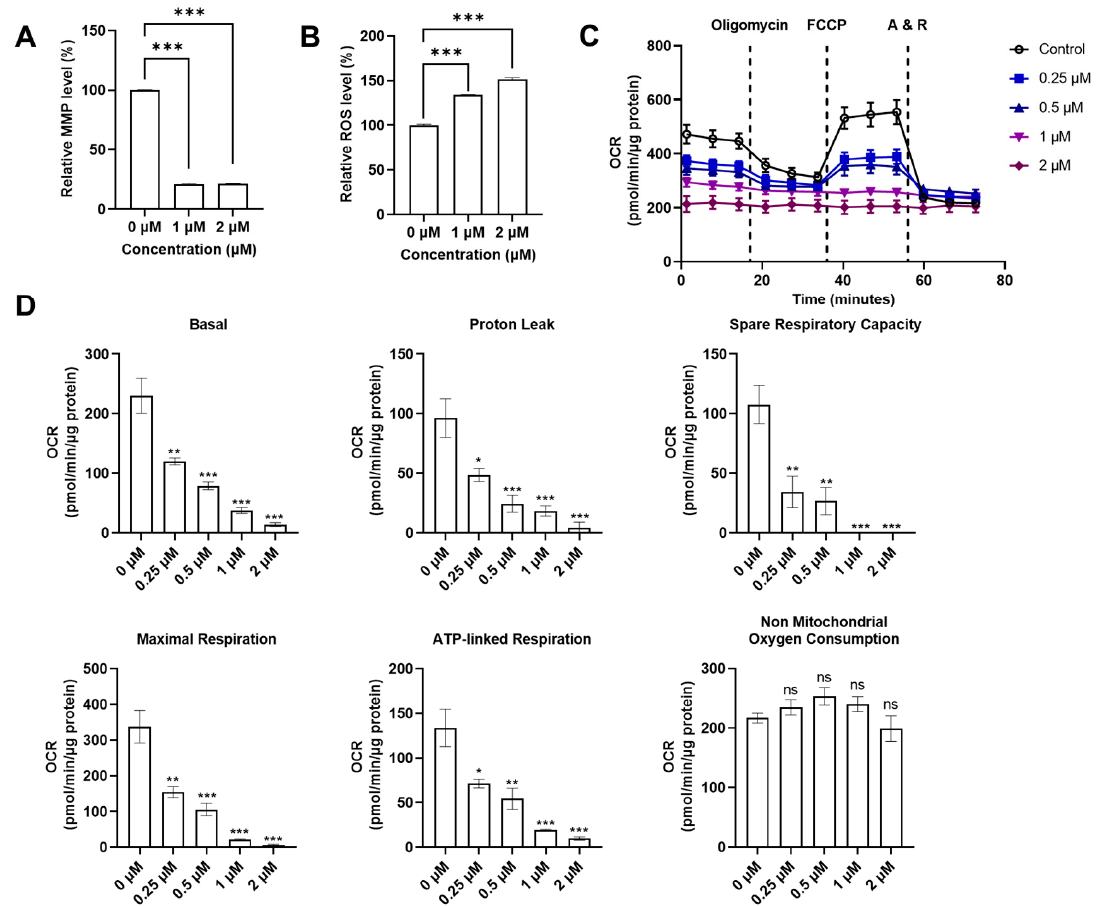
Figure 4. Systematical evaluation of mitochondrial functions with QUCO-1 treatment after 24